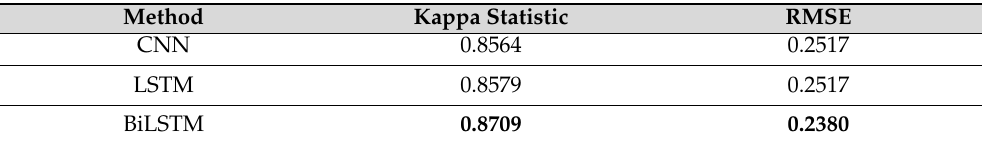
Table 12. Kappa statistics and RMSE values of deep learning algorithms on cancer prediction with all attributes. (Illustrations by the authors).